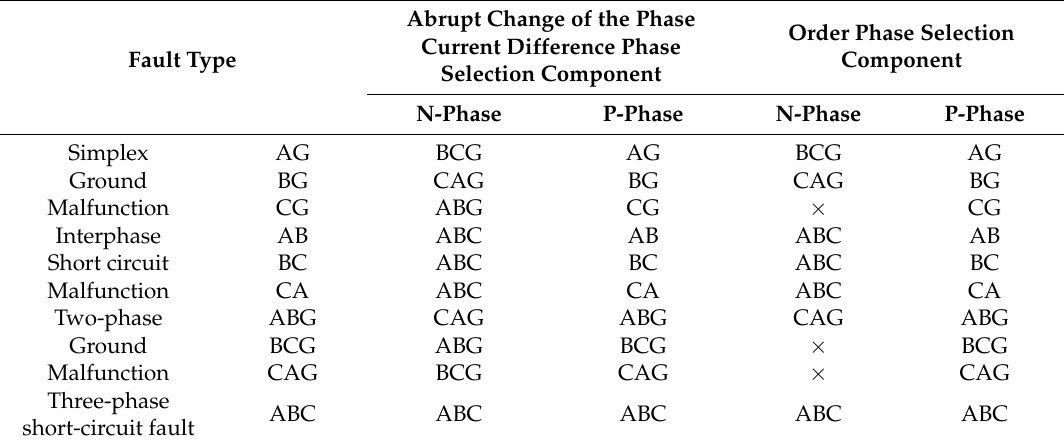
Table 1. Fault analysis results at Fault Point (F) for phase